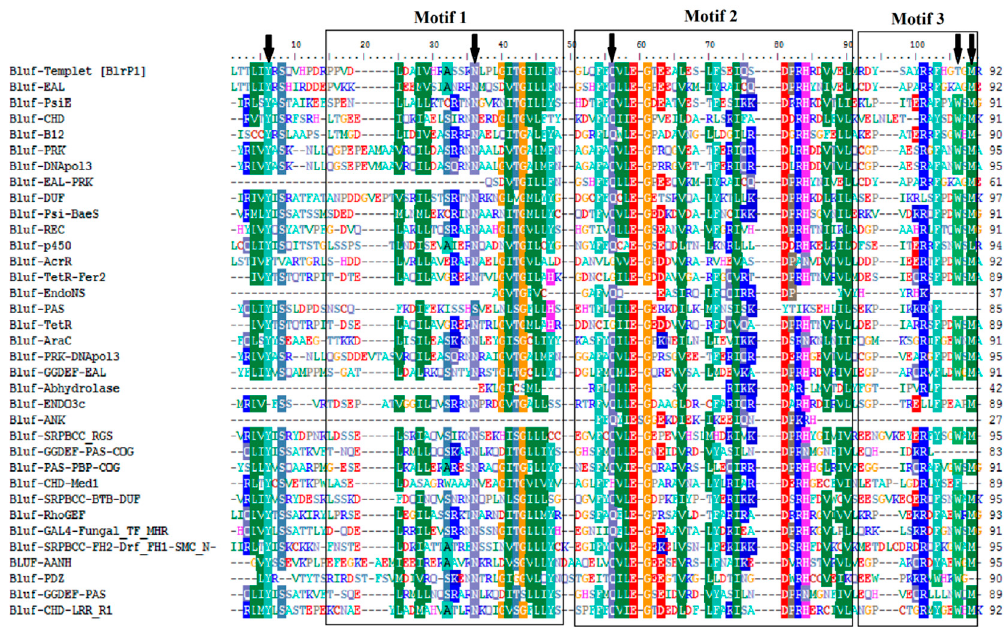
Figure 2. Multiple sequence alignment of the different BLUF modular domains depicting conserved amino acids. The black arrow indicates conserved amino acids crucial for regulating the flavin binding pocket, photocycle and photodynamics of the BLUF domain containing proteins [6,11]. The sequences under the solid boxes represent the conserved motifs of the BLUF domain. The conserved motifs were predicted using the Multiple EM for the Motif Elicitation (MEME) suite.